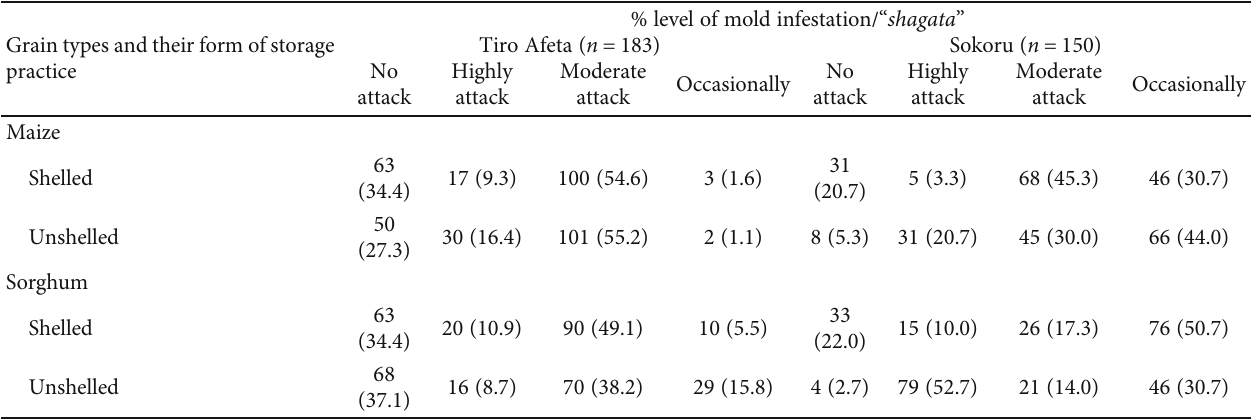
Table 5: Farmers ’ estimation level of visible mold infestations on stored